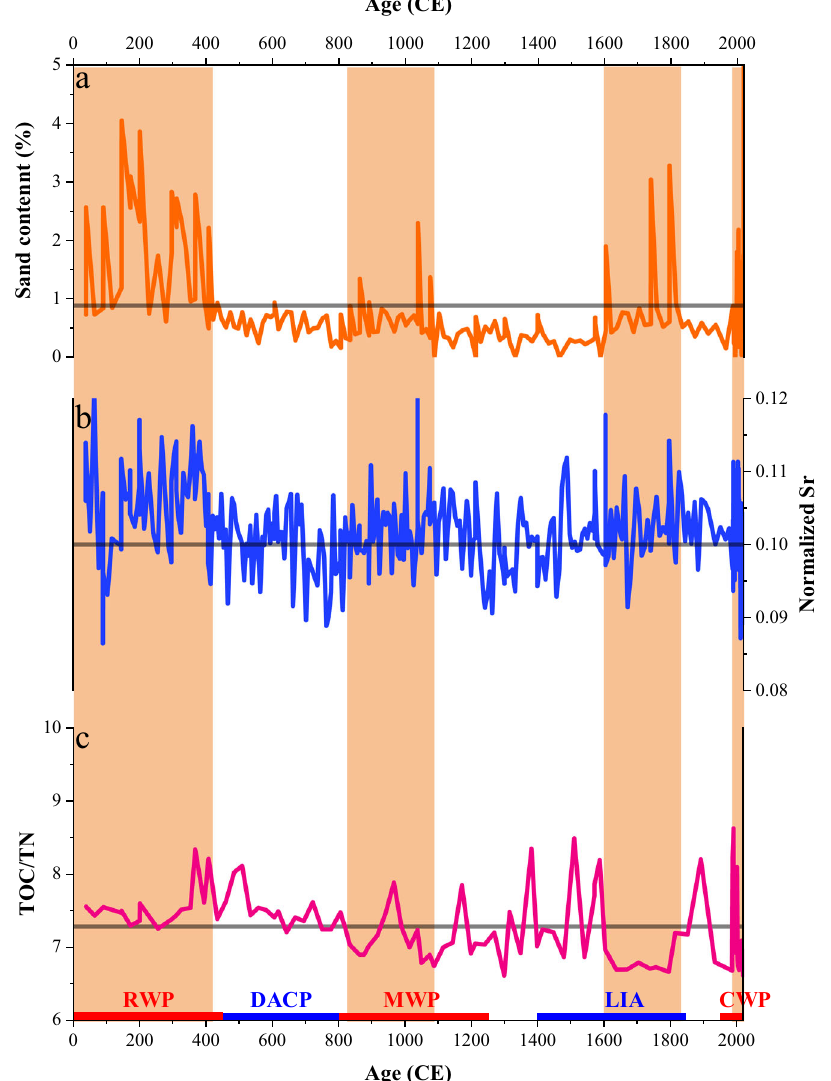
Fig. 3 Grain size and geochemical records of core ZM01 from the ZFMB. a Sand content, b Normalized Sr (normalized to total XRF counts), and c TOC/ TN ratio. The gray line represents the average value of each parameter. The orange- fi lled columns represent periods of increased TC activity. The Sr content does not always match the sand content, which is most likely due to the narrower window of the Avaatech XRF (Fig. S1) compared to grain size